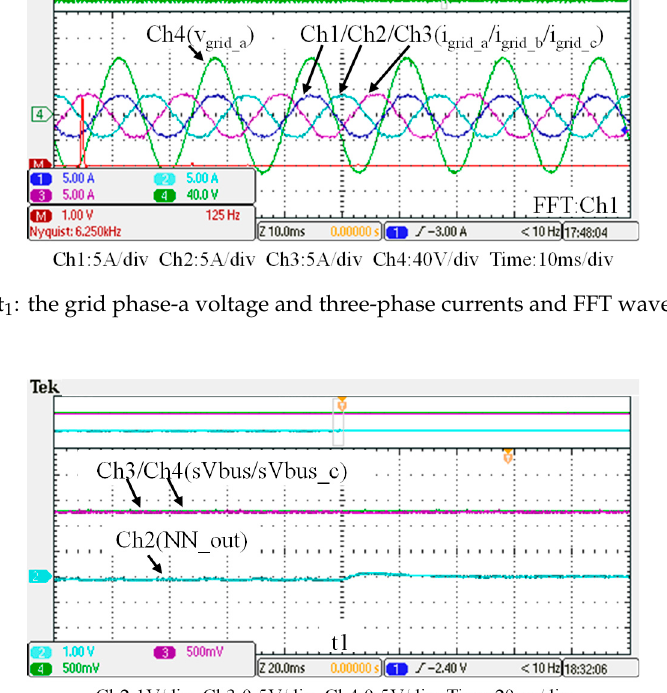
Figure 23. The command and feedback signals of DC link voltage and the proportional-integral (PI) controller output signal (t 0 –t 2 ).